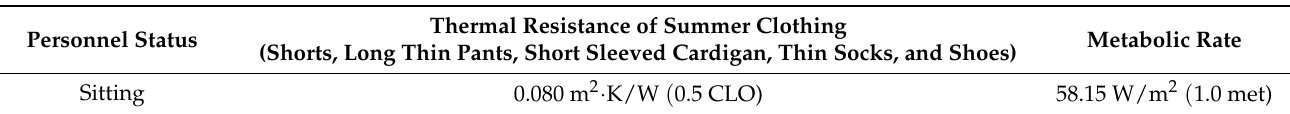
Table 2. Parameter settings of office staff